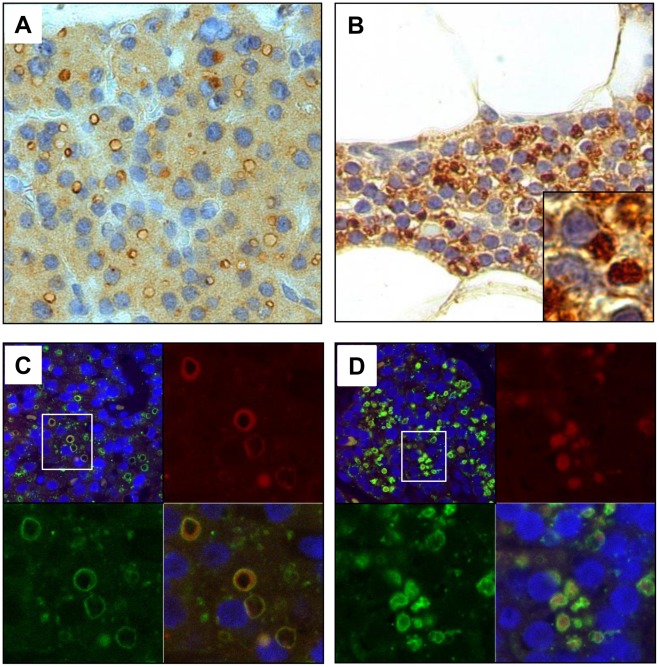
Localisation of PRLr expression to lysosomes in normal parathyroid rim and to enlarged lysosomes in parathyroid tumour tissue.A) Immunohistochemistry with PRLrI showing “ring-like” cytoplasmic structures and cytoplasmic reactivity. B) Immunohistochemistry of PRLrI showing cytoplasmic granuale and cytoplasmic reactivty. C and D) Analysis of “ring like” structures and cytoplasmic granulae by flourescent immunohistochemistry. Images show one parathyroid tumour (C) and normal parathyroid rim (D), stained with DAPI (blue), anti-PRLrI (red, upper right) and anti-SCARB2 (green lysosomal marker, lower left) separately and in overlay (lower right and upper left).